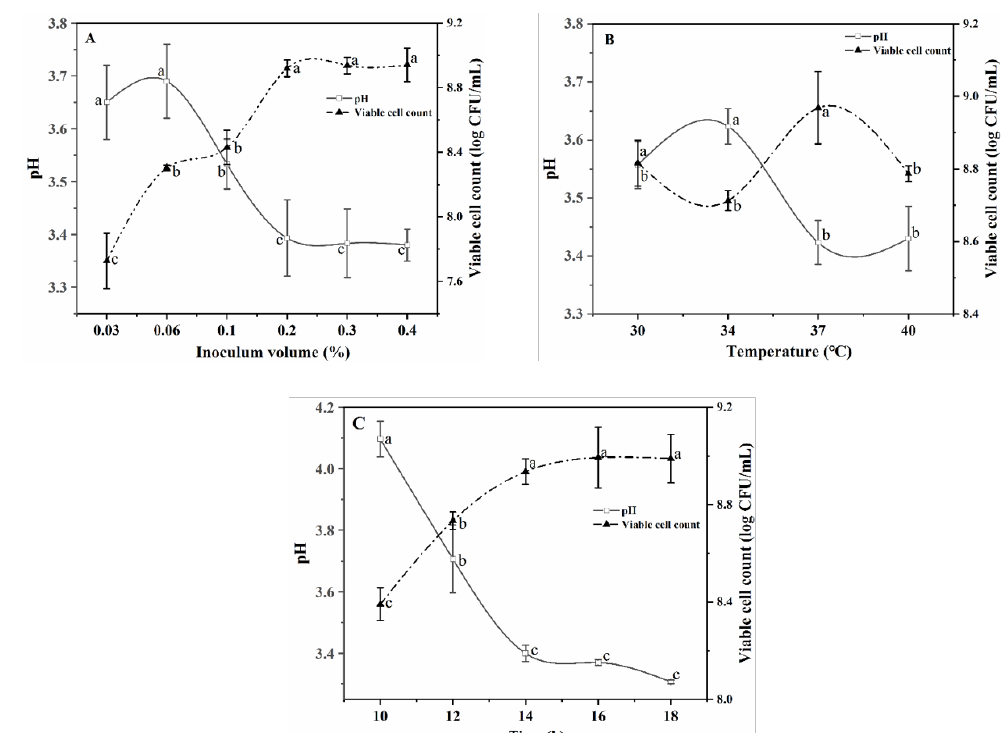
Figure 1. Changes in pH values and viable cell counts under different inoculation volumes ( A ) (0.03%, 0.06%, 0.10%, 0.20%, 0.30%, and 0.40% with separate trials at 37 ◦ C and fermented for 14 h), fermentation temperatures ( B ) (30 ◦ C, 34 ◦ C, 37 ◦ C, and 40 ◦ C with separate trials with 0.30% inoculation volume and fermented for 14 h), and fermentation time periods ( C ) (10 h, 12 h, 14 h, 16 h, and 18 h with consecutive trials under different time points with 0.30% inoculation volume and fermented at 37 ◦ C) with L. plantarum TUST-232. a,b,c Statistical analysis ANOVA at 95% confidence level, with different letters indicating a significant difference at p < 0.05.